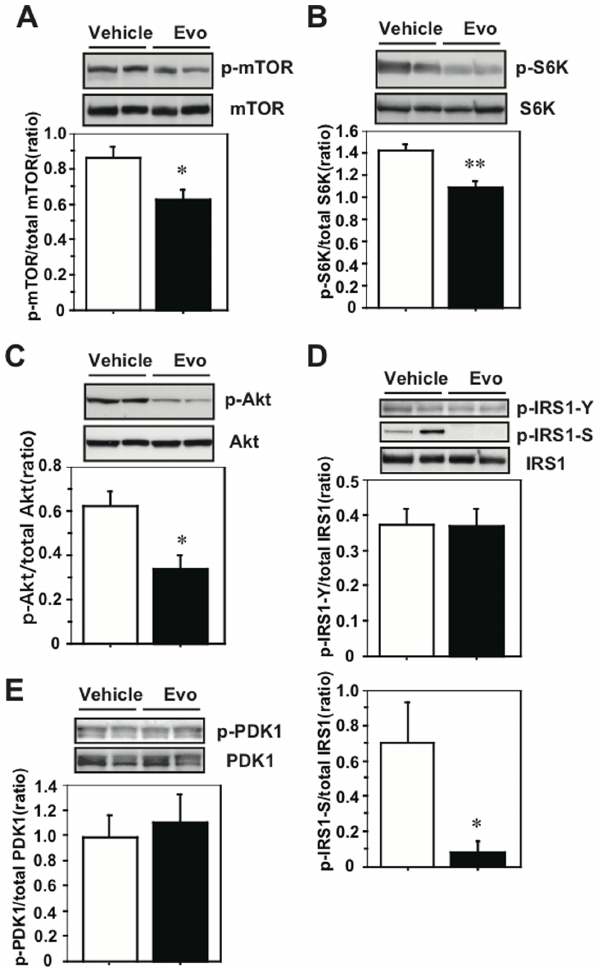
Figure 3. Effect of evodiamine on the mTOR-S6K signaling in the inguinal WAT (IWAT) of mice treated with evodiamine. Western blot analysis for mTOR (A), S6K (B), Akt (C), IRS1 (D) and PDK1 (E) were done with tissue lysates (30 m g protein) of IWAT from the KK-Ay mice treated with evodiamine for 7 days. Phosphorylation levels of mTOR Ser2448, S6K Thr389, Akt Ser473, IRS1 Tyr612 and Ser636/639, and PDK1 Ser241 were normalized to the total level of each protein. Data are expressed as mean 6 SEM ( n =5). * p , 0.05, ** p , 0.01 vs. vehicle group.